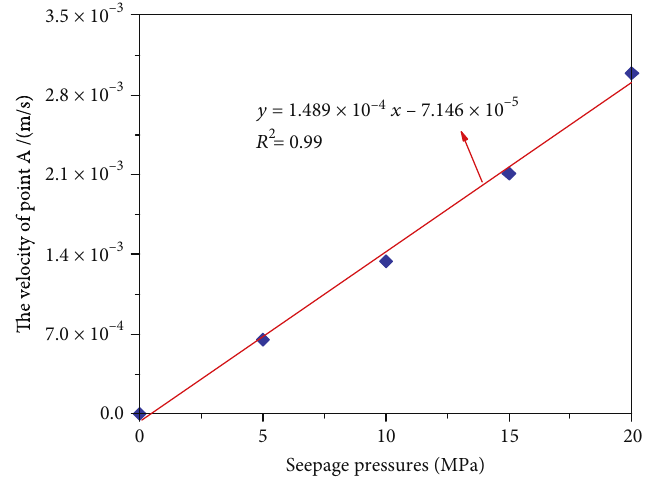
Figure 17: The relationship between the velocity change of point A and water pressure of karst cave.